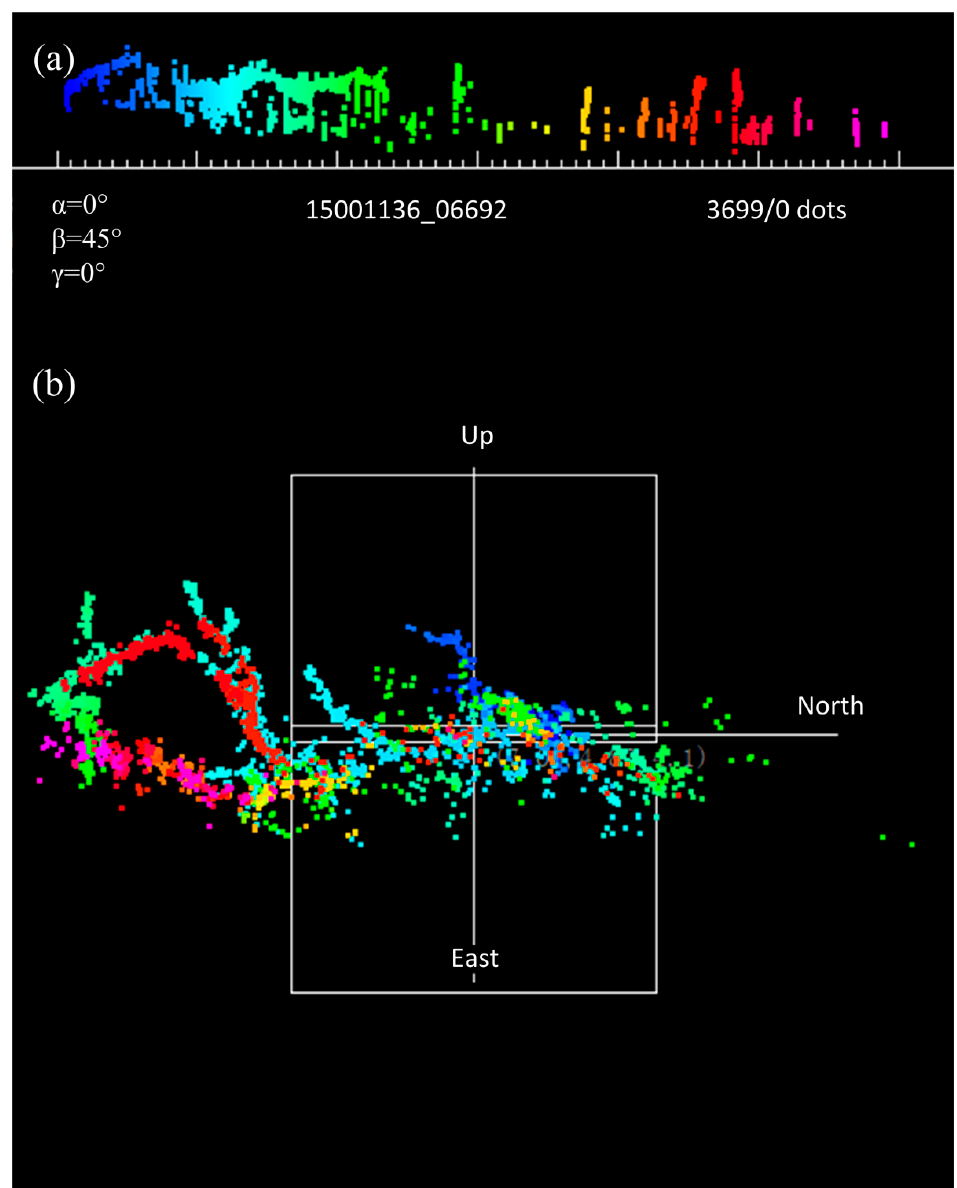
Figure 10. The 45° angle top view to the horizontal of IC flash 001136 from east to west. ( a ) Height- time plots and ( b ) the 45° top view from east to west.